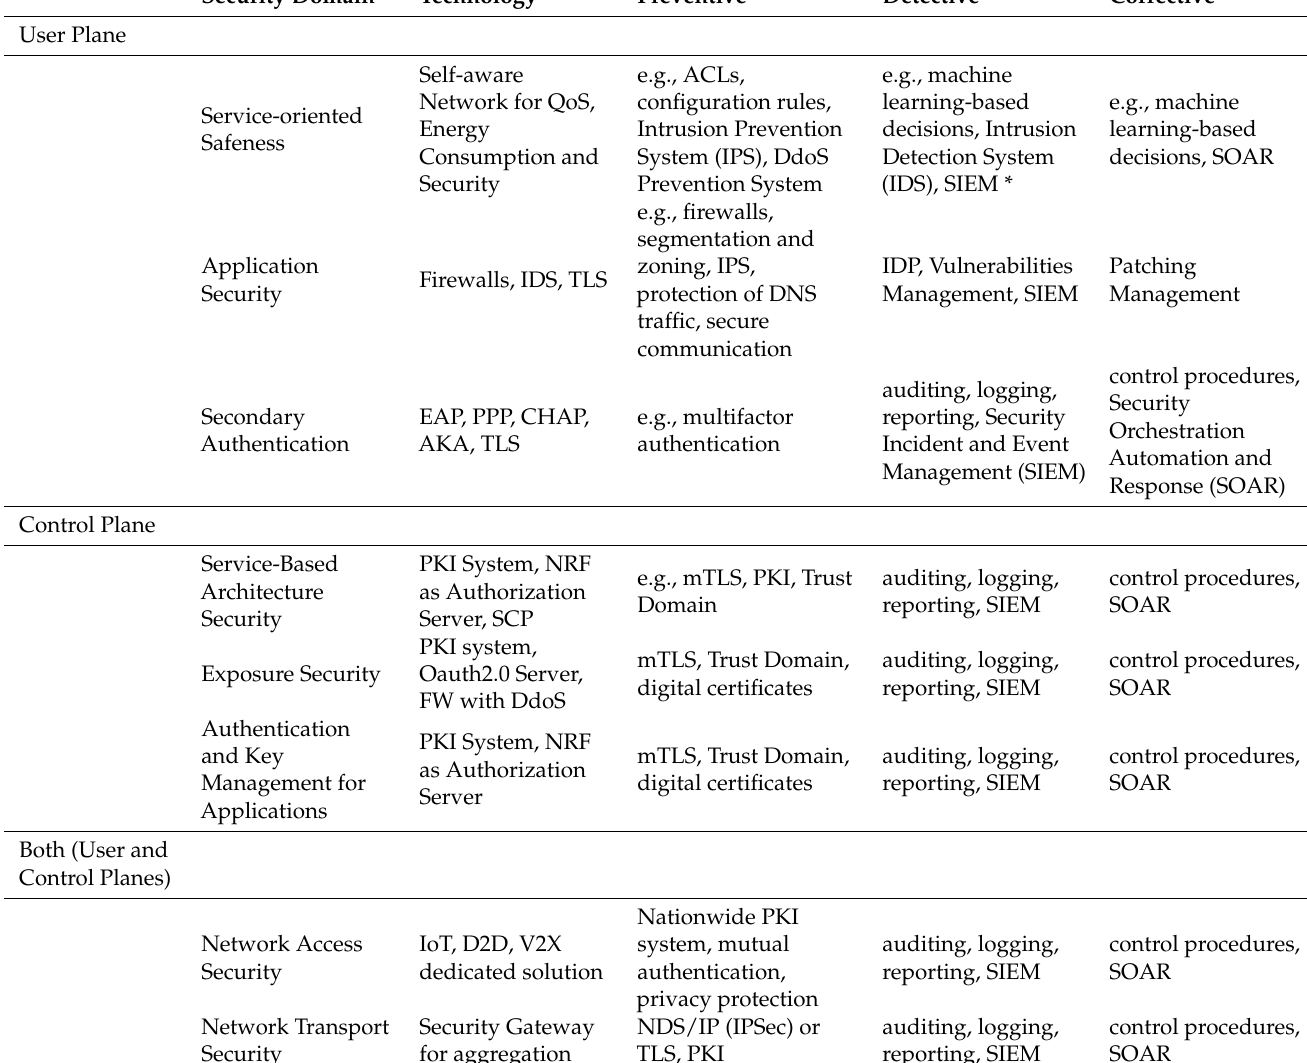
Table 2. Security control type and technology in 5G